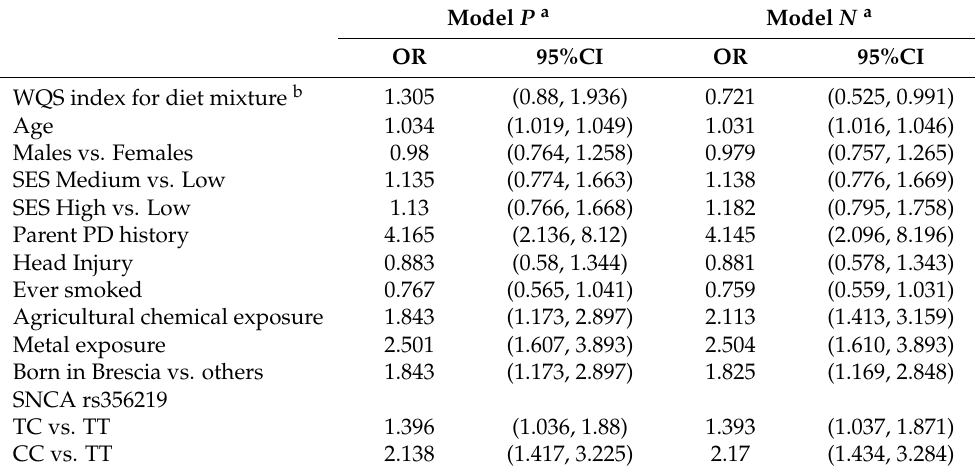
Figure 1. Boxplots of the weights estimated through the Weighted Quantile Sum (WQS) regression representing the distribution generated by the 100 repeated holdout validations for each element considered in the mixture. The set of weights are those associated with the nutrient mixture index with a protective effect on PD. The diamond corresponds to the weight mean value for each nutrient. The red dashed line is the prespecified threshold (equal to the inverse of the number of elements in the mixture: 1/8) to establish the weights different from 0. Table 3. Weighted Quantile Sum (WQS) regression examining the relationships of diet mixture and environmental and genetic factors with PD. Odds ratios (OR) and 95% confidence intervals (CI) are